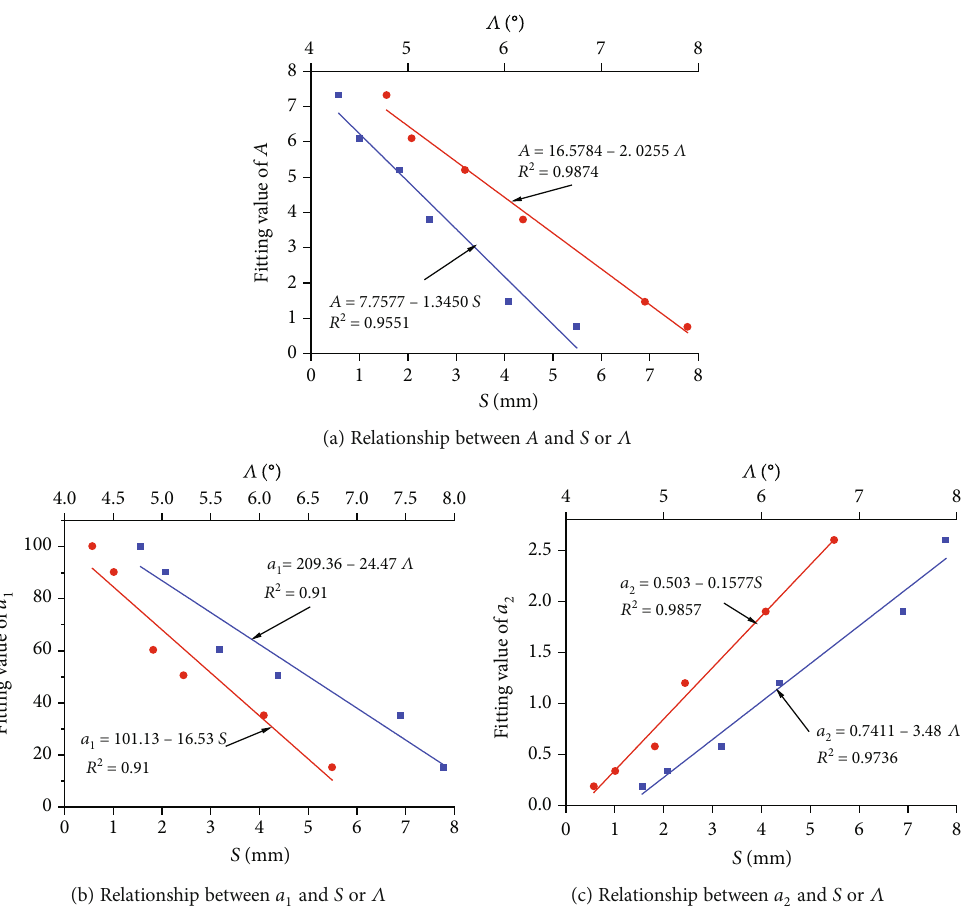
a S and Λ . 1 , and 2 and